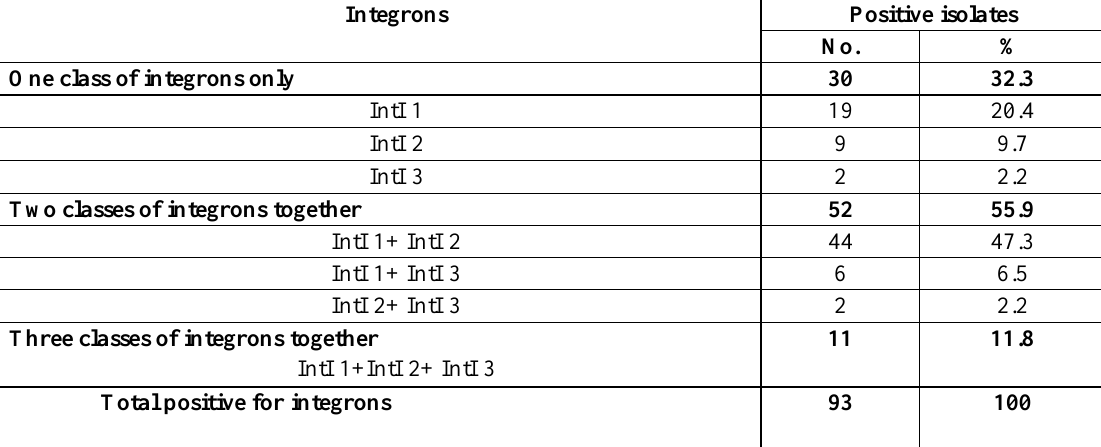
Table 2. Distribution of the 93 P. mirabilis isolates positive for integrons according to the coexistence of different classes of